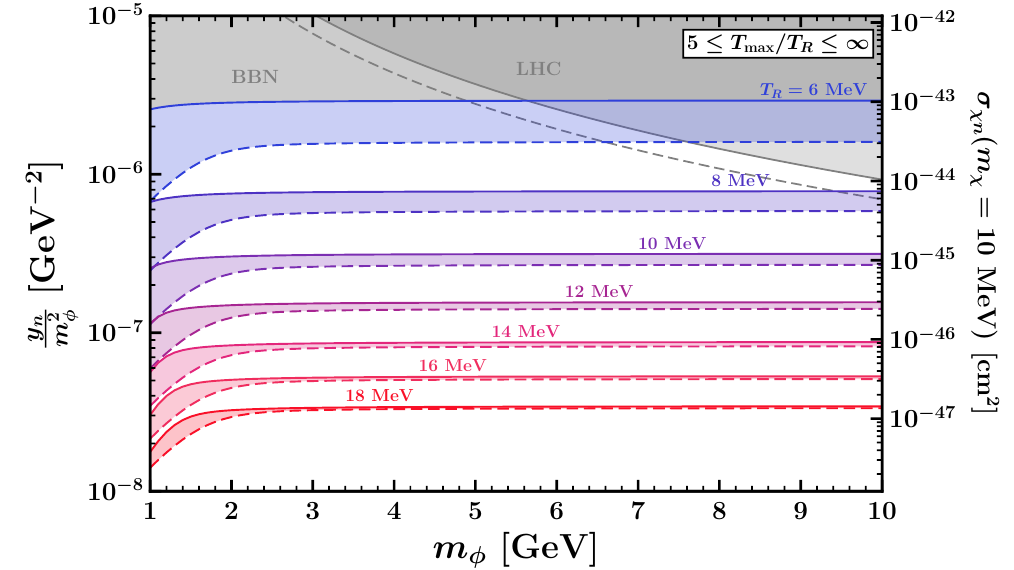
Figure 5 . Predictions for y n /m 2 as a function of m φ along with constraints in gray for y ψ = φ y χ = 1 . The colored bands yield the correct relic abundance for m χ = 10 MeV for various reheating temperatures (as labeled) and 5 ≤ T max /T R ≤ ∞ (band width). The right vertical axis is the scattering cross section for m χ = 10